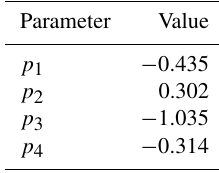
Table 3. Fitted parameter values for the logistic relationship be- tween sediment porosity and median grain size in the top 10cm of seabed